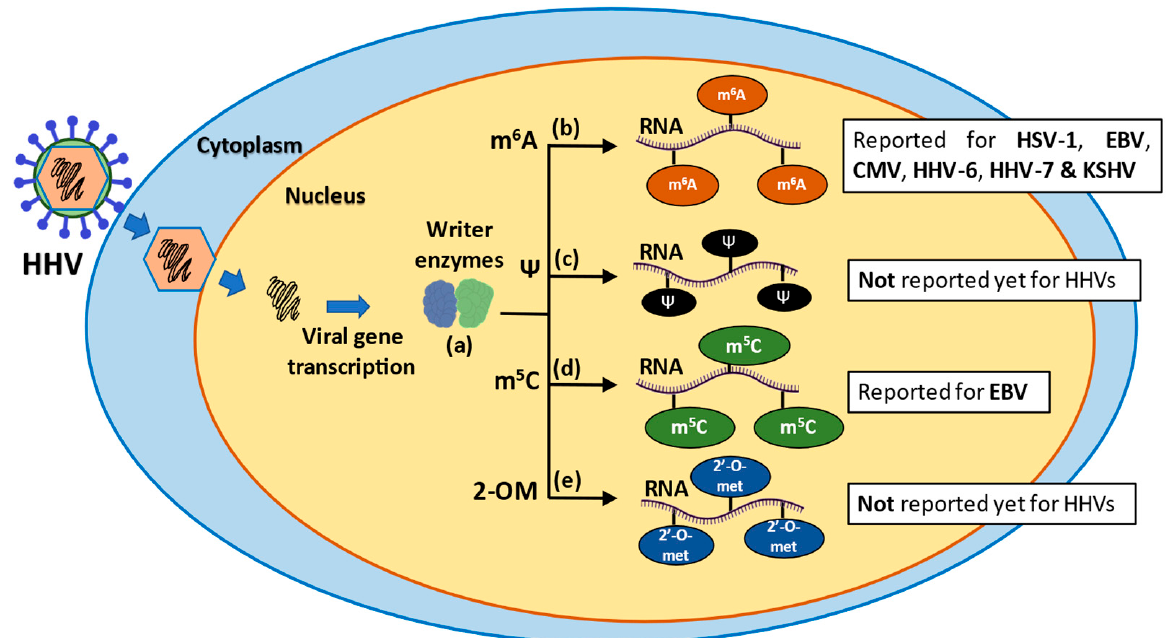
Figure 1. Schematic representation of epigenetic modifications in RNA molecules during human herpesvirus (HHV) infections. (a) After the introduction of the viral DNA into the cytoplasm and posterior transcription of viral genes, writer enzymes perform various epigenetic modifications, such as methyl 6-adenosine (m 6 A), pseudouridylation ( Ψ ), methyl-5 cytosine (m 5 C) and 2 ′ -O-methylation (2-OM). (b) The m 6 A modification is the most prevalent modification in mRNA and takes place during pre-mRNA synthesis in the nucleus. (c) Pseudouridylation is the most abundant modification in stable RNAs, it is irreversible and occurs through two pathways: an RNA-dependent pathway and RNA-independent pathway. (d) The m 5 C modification is related to improved function and stability of RNA molecules. (e) The 2-OM modification is found in rRNA and tRNA molecules and is associated with increased stability and translation modulation of mRNAs.